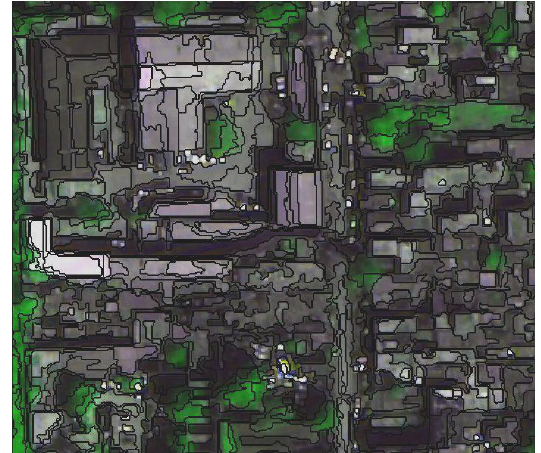
Figure 5 A portion of the segmentation result (black lines) overlapped on the false colour composite image (band 3, 4, 2 as R, G,